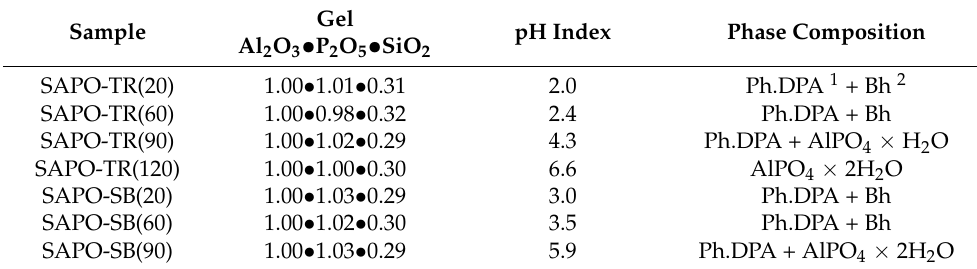
Figure 1. X-ray patterns of initial SAPO-gels prepared using various boehmites: ( a ) Sample SAPO- TR(20); ( b ) Sample SAPO-SB(20); ( c ) SAPO-RP(20). Table 2. Chemical and phase composition of the